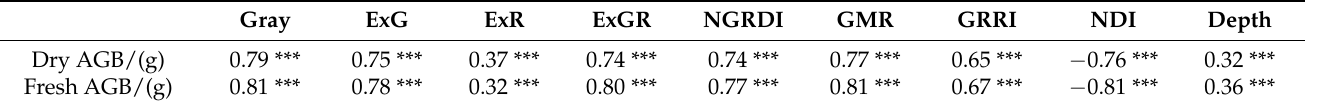
Table 3. Correlation analysis between image features and dry and fresh AGB.